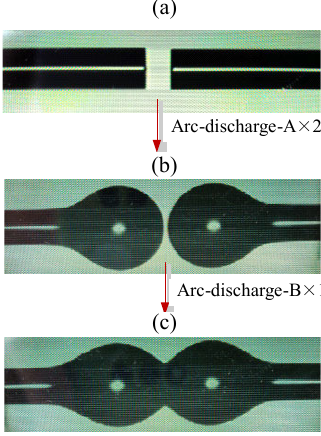
Fig. 2 Fabrication process of the peanut taper with microscopic images of (a) two cleaved SMFs, (b) SMFs with spherical end, and (c) peanut